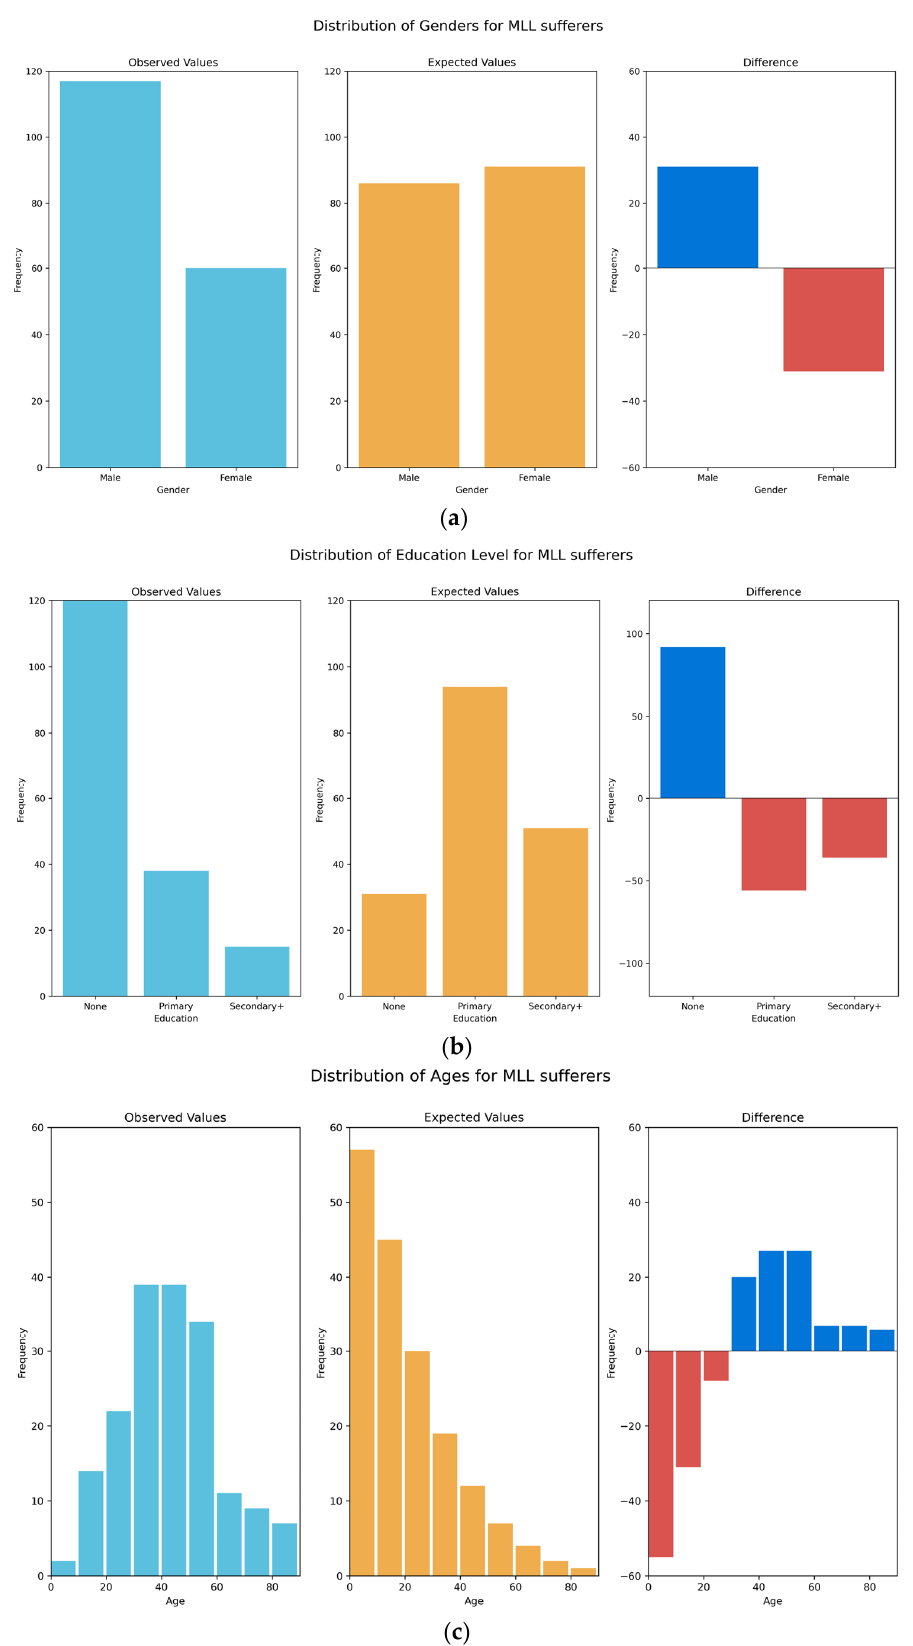
Figure 3. Comparison of the observed and expected distribution of ( a ) gender, ( b ) education and ( c ) age for those with MLL in the Acholi sub-region.